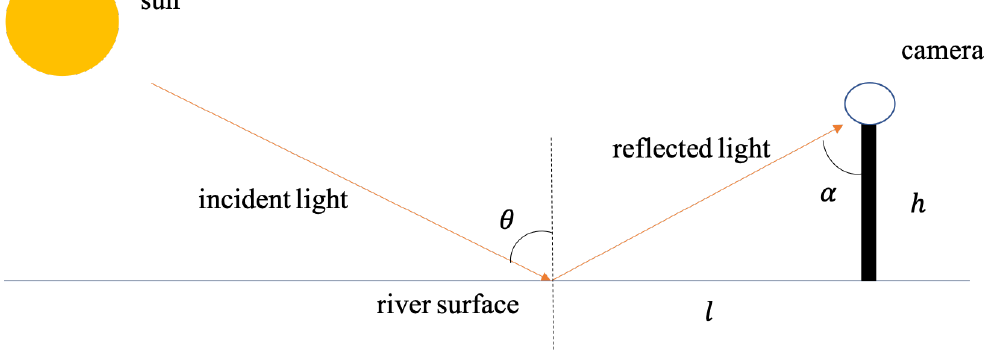
Figure 2. Light path diagram of river